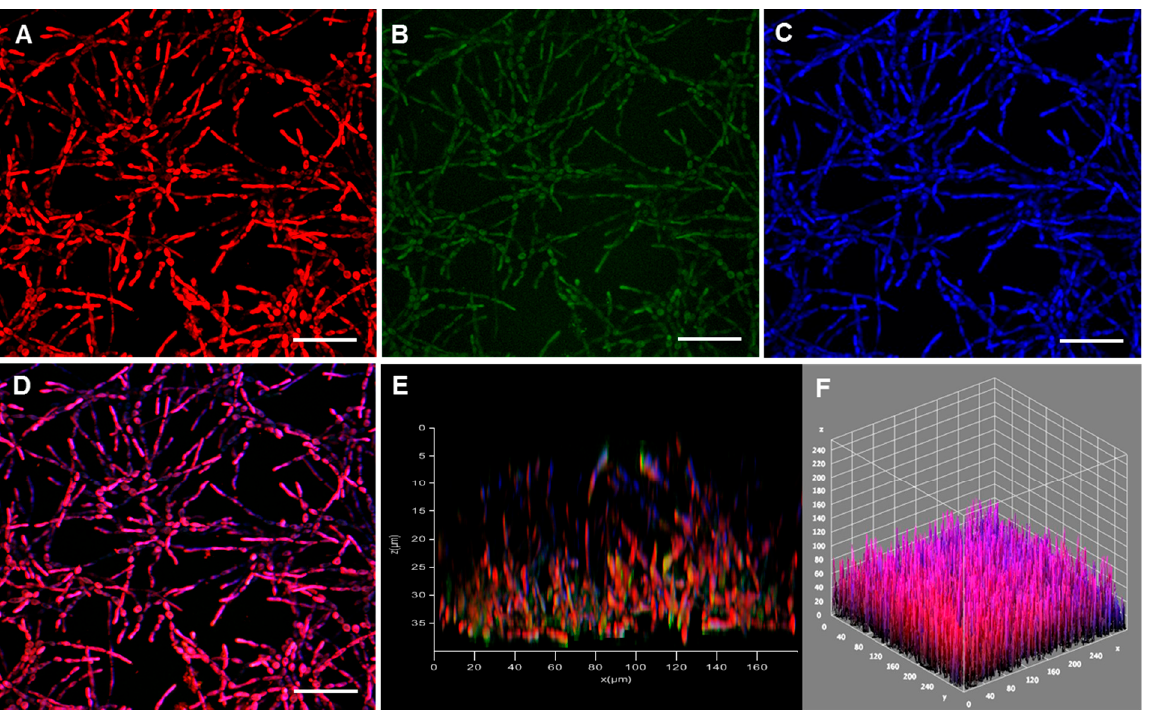
Figure 3. Confocal microscopy of the biofilm formed by F. pedrosoi cells on polystyrene. Conidia (1 × 10 6 ) were incubated at 37 °C in polystyrene confocal plates containing RPMI medium. After 48 h, the fungal cells were stained with ( A ) FilmTracer SYPRO ® , ( B ) TOTO TM , ( C ) calcofluor white M2R and ( D ) the staining combined. ( E , F ) 3-D reconstructions of the fungal biofilm. Bars, 20 µm.